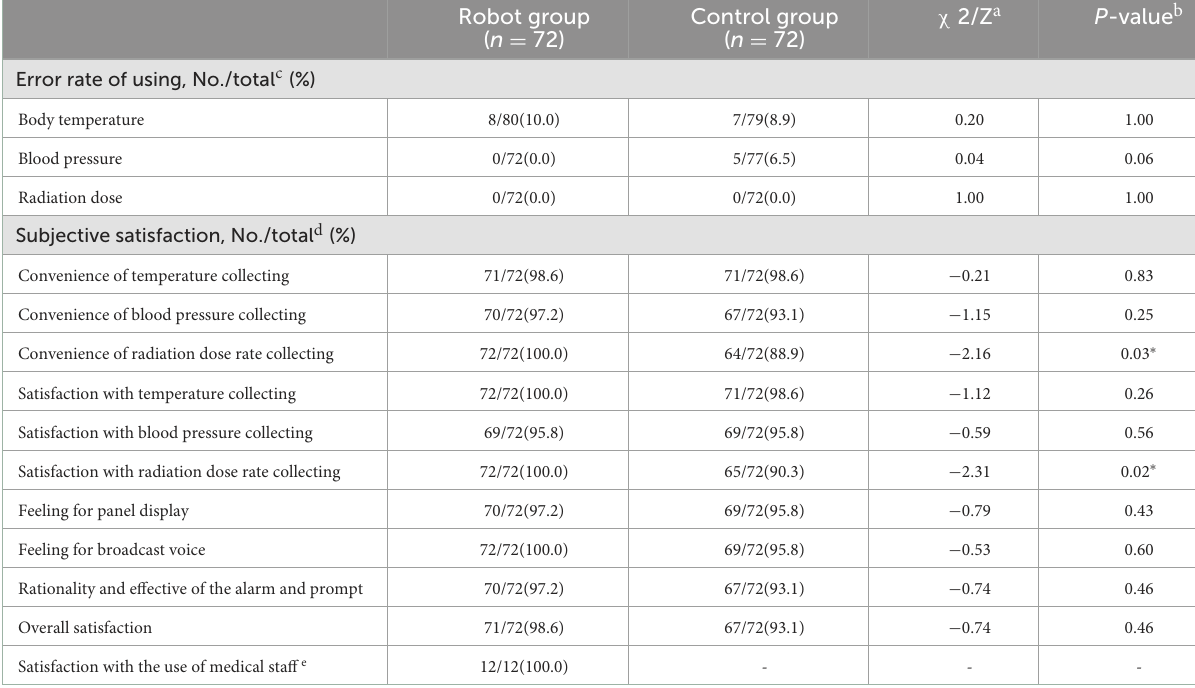
TABLE 4 Secondary clinical outcome of the error rate of using and subjective